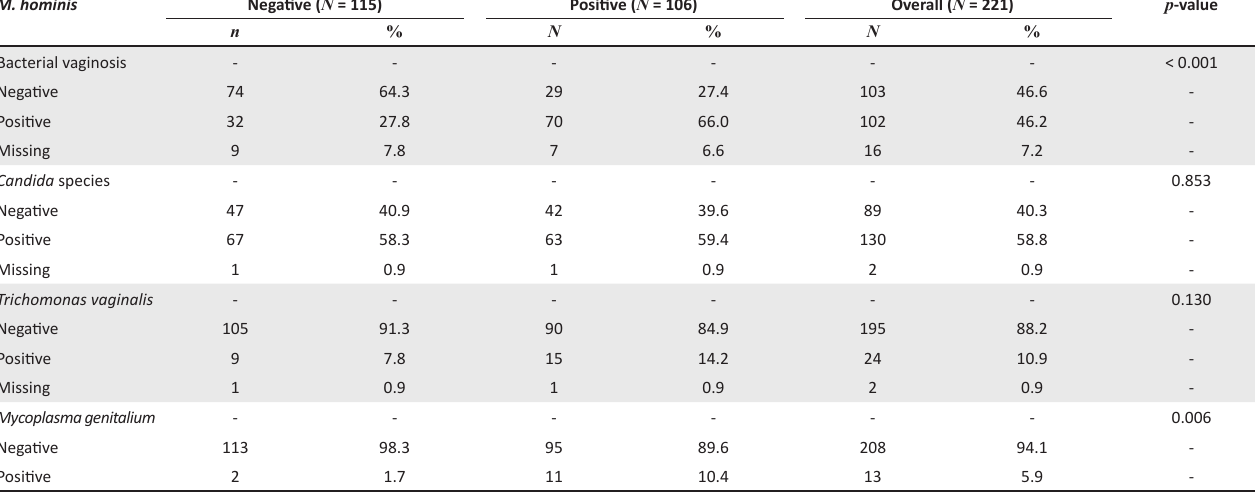
TABLE 3: Coinfection between Mycoplasma hominis and genital tract infections. M. hominis